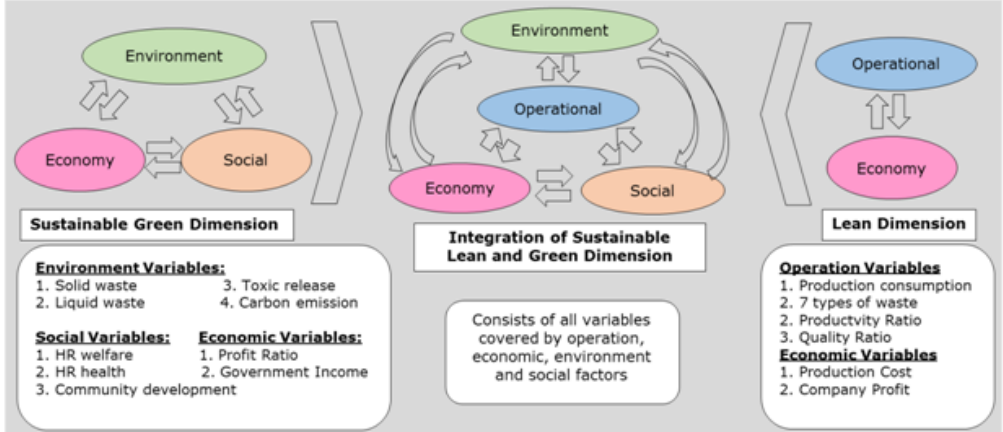
Figure 1. Integration of the lean and green concepts